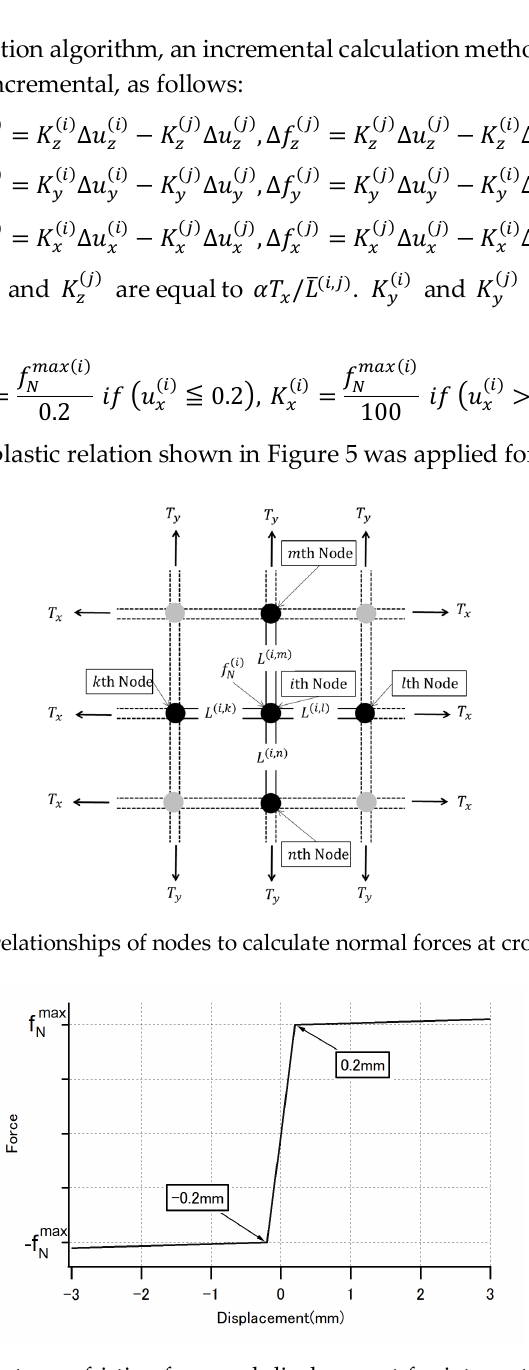
Figure 5. Relationship between friction force and displacement for intersections of main and cross